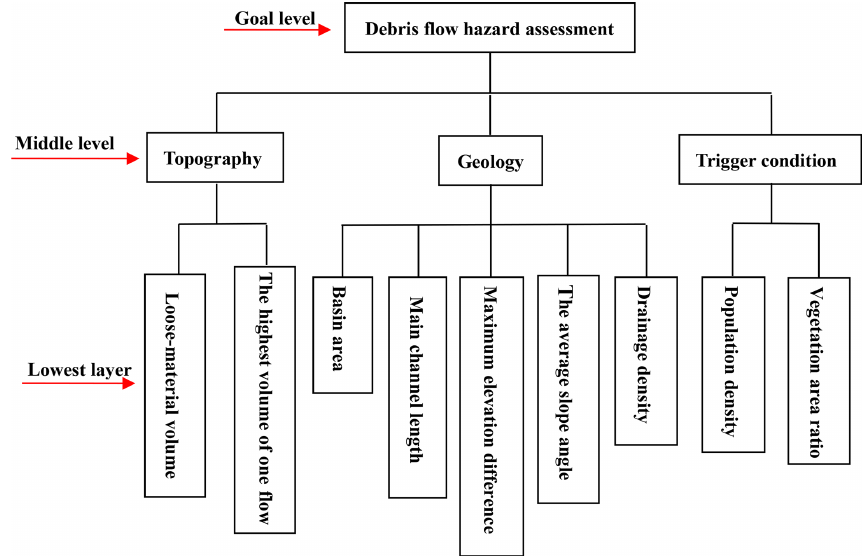
Figure 10. Hierarchical structure for debris flow susceptibility analysis.